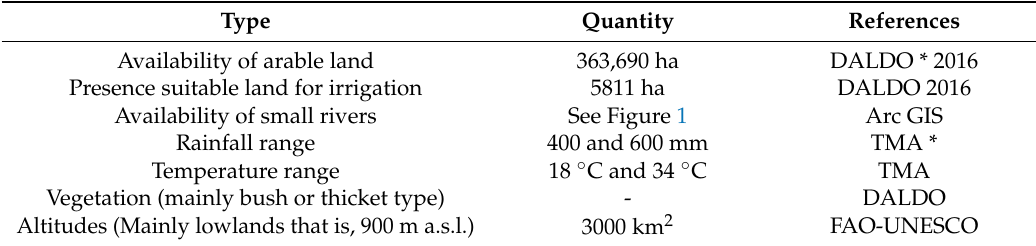
Table 4. Main Biophysical Resources in the Sampled Villages.